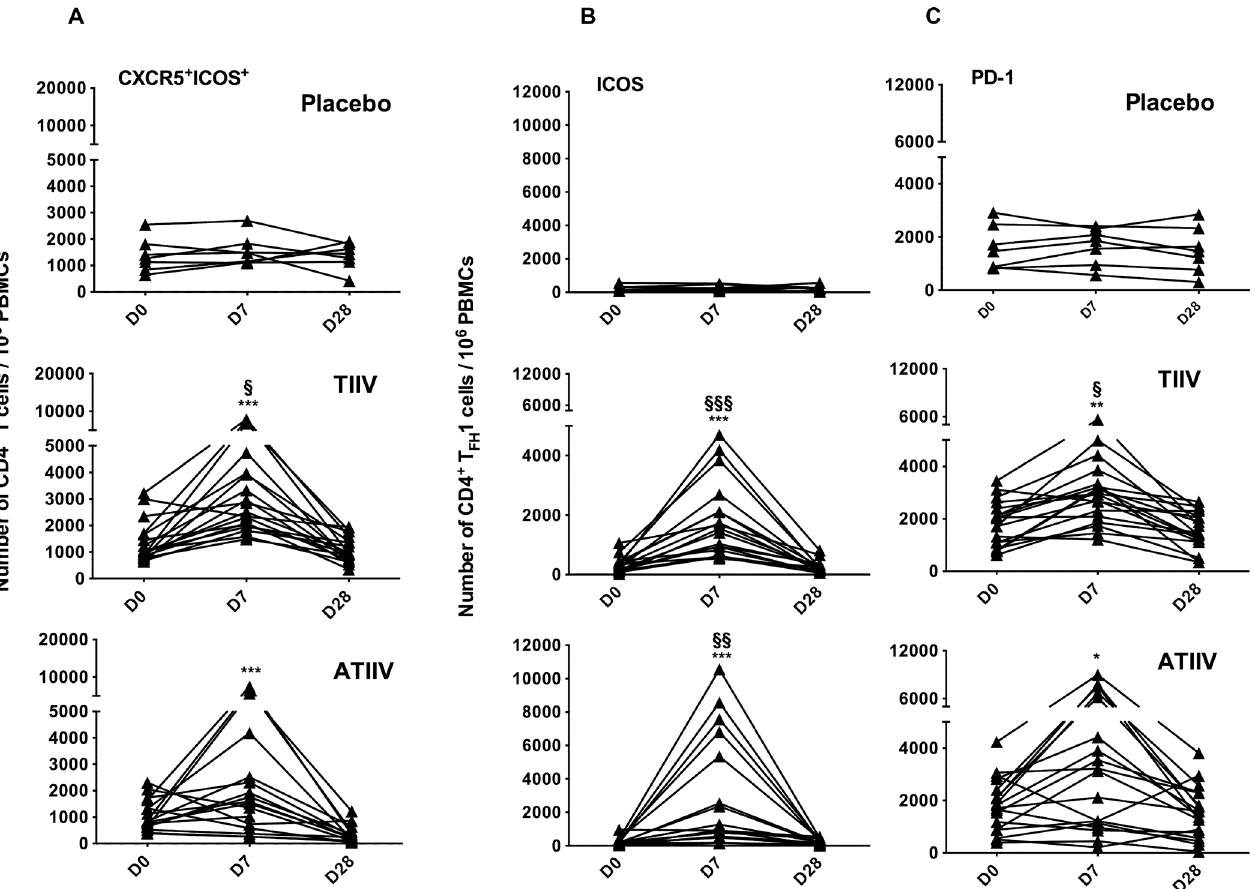
Fig 3. Expansion of ICOS + and PD-1 + T FH 1 cells after TIIV and ATIIV vaccination. ( A ) Number of CD4 + T cells expressing CXCR5 and ICOS in human PBMCs after seasonal influenza vaccination. ( B and C ) Number of T FH 1 cells expressing ICOS and PD-1. Data show three cohorts: saline placebo (n=7), TIIV (n=18) and ATIIV (n=17) at baseline (D0), day 7 (D7) and day 28 (D28) after a single dose of influenza vaccine. Data are shown for each participant and expressed as number of cells in 10 6 live PBMCs acquired. Non-parametric Wilcoxon ’ s signed rank test was used for statistical analyses: * p < 0.05, ** p < 0.01, and *** p < 0.001 compared to day 0; § p < 0.05, §§ p < 0.01 and §§§ p < 0.001 compared to saline placebo.